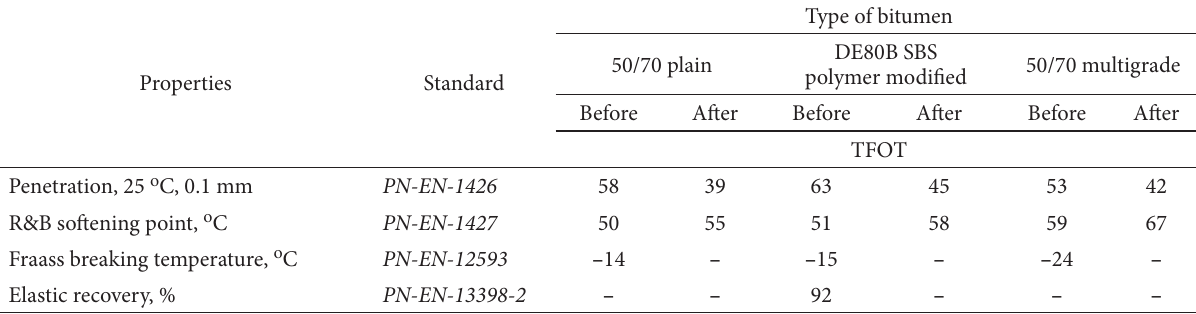
Table 1. Properties of plain, polymer modified and multigrade type